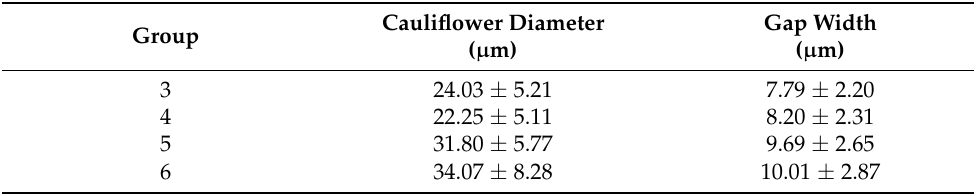
Table 2. Dimensions of the cauliflower structures.